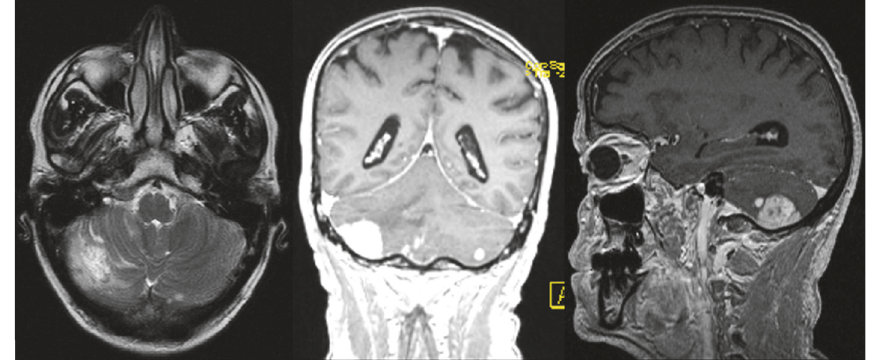
Figure 2: Magnetic resonance imaging showing multiple bilateral lesions in the cerebellum with strong and irregular contrast enhancement, central necrosis, and mass